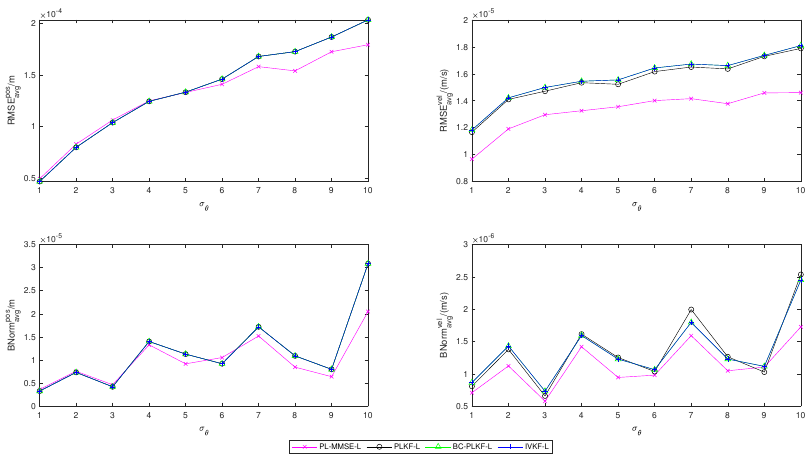
Figure 11. Time-averaged RMSEs, BNorms and bearing noise standard deviation at V = 10 − 4 m/s for the four algorithms combined with the second-order approximation